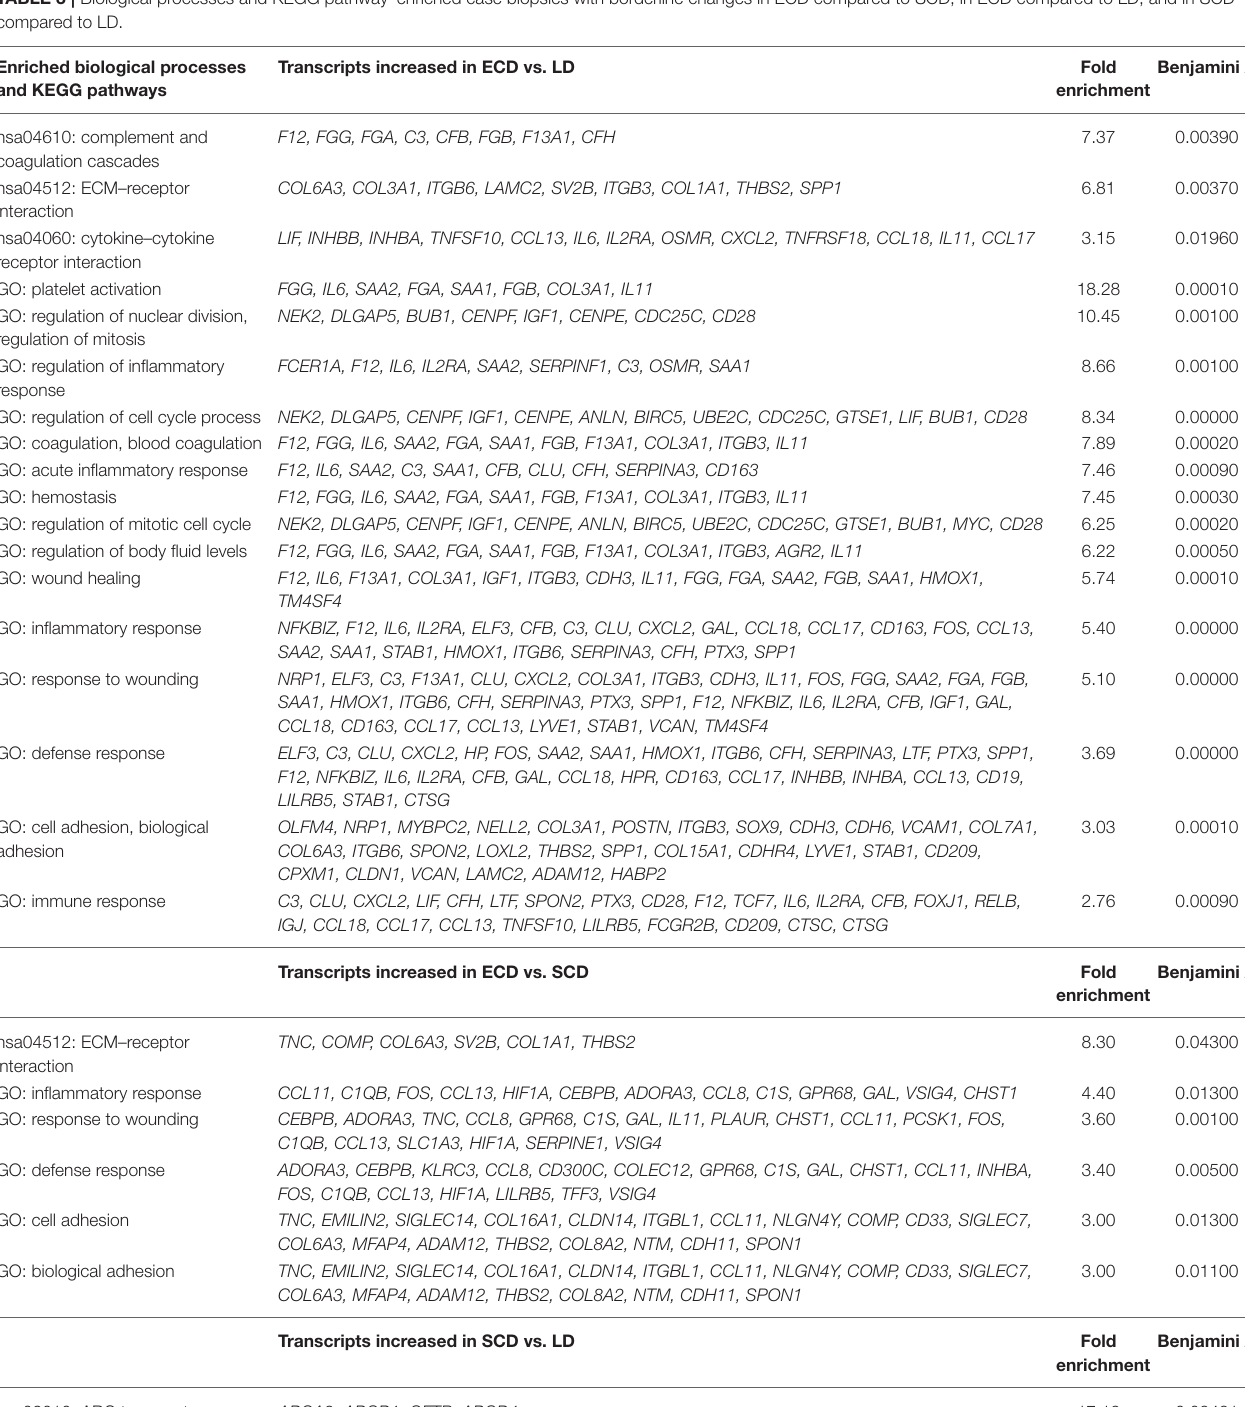
TABLE 3 | Biological processes and KEGG pathway–enriched case biopsies with borderline changes in ECD compared to SCD, in ECD compared to LD, and in SCD compared to LD. Enriched biological processes and KEGG